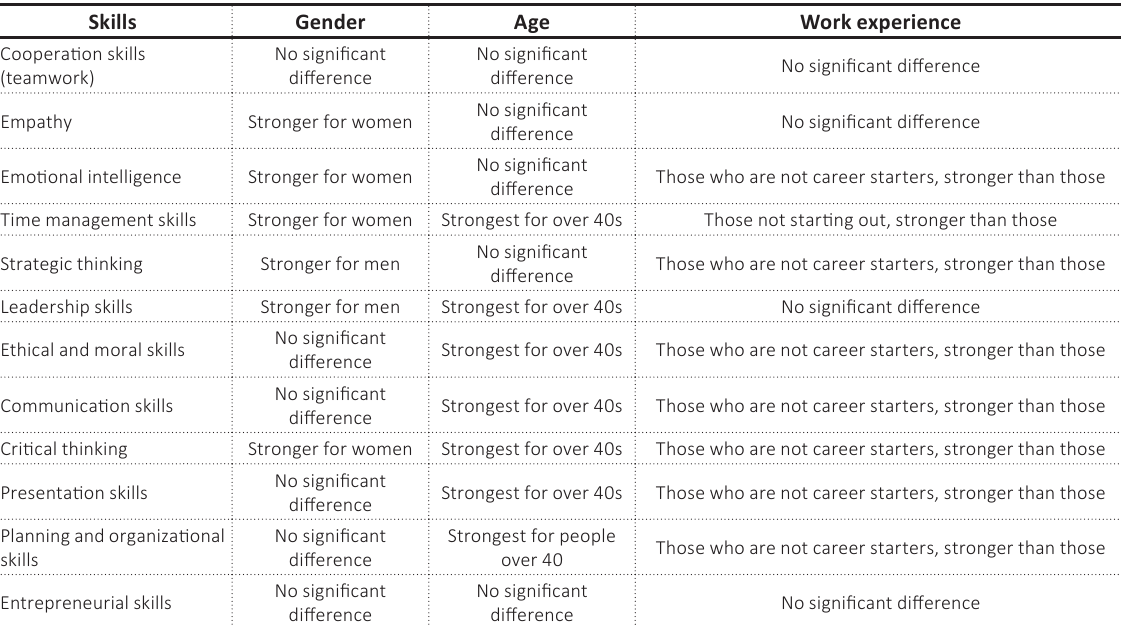
Source: Own table.